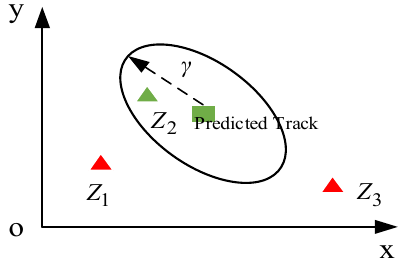
Figure 2. Threshold graph of ellipse tracking.